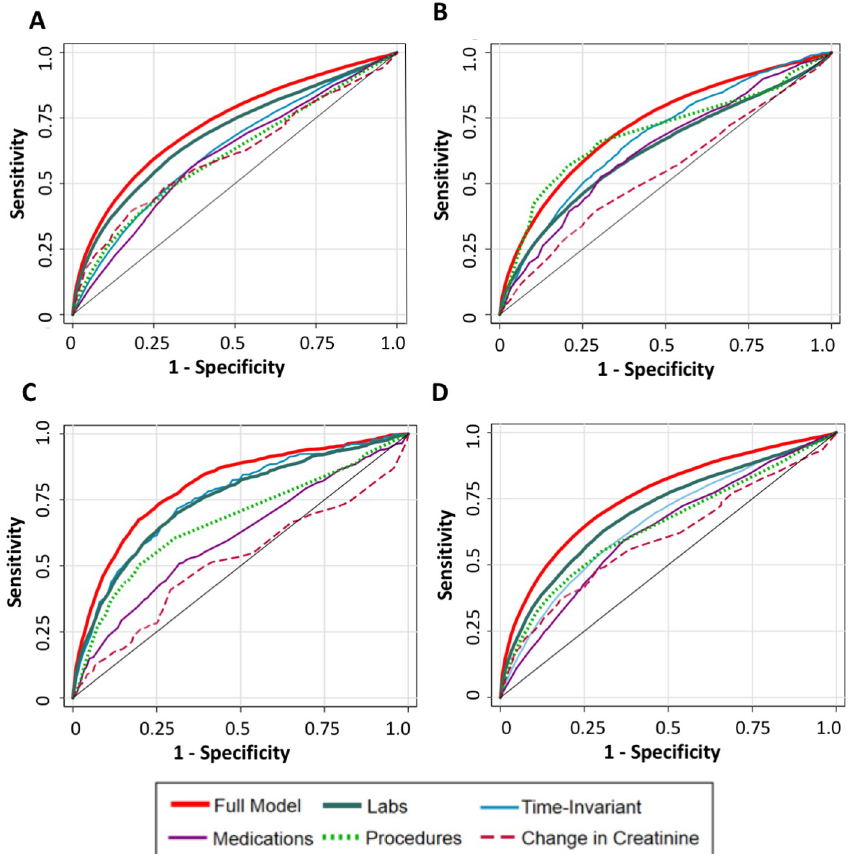
Fig 3. ROC curves of the various AKI models. Curves reflect performance in a test set composed of a combination of the internal and external validation cohorts. (A) Prediction of AKI in 24 hours. (B) Prediction of hospital mortality. (C) Prediction of need for renal replacement therapy. (D) Prediction of sustained AKI. AKI, acute kidney injury; ROC, receiver-operator characteristic.